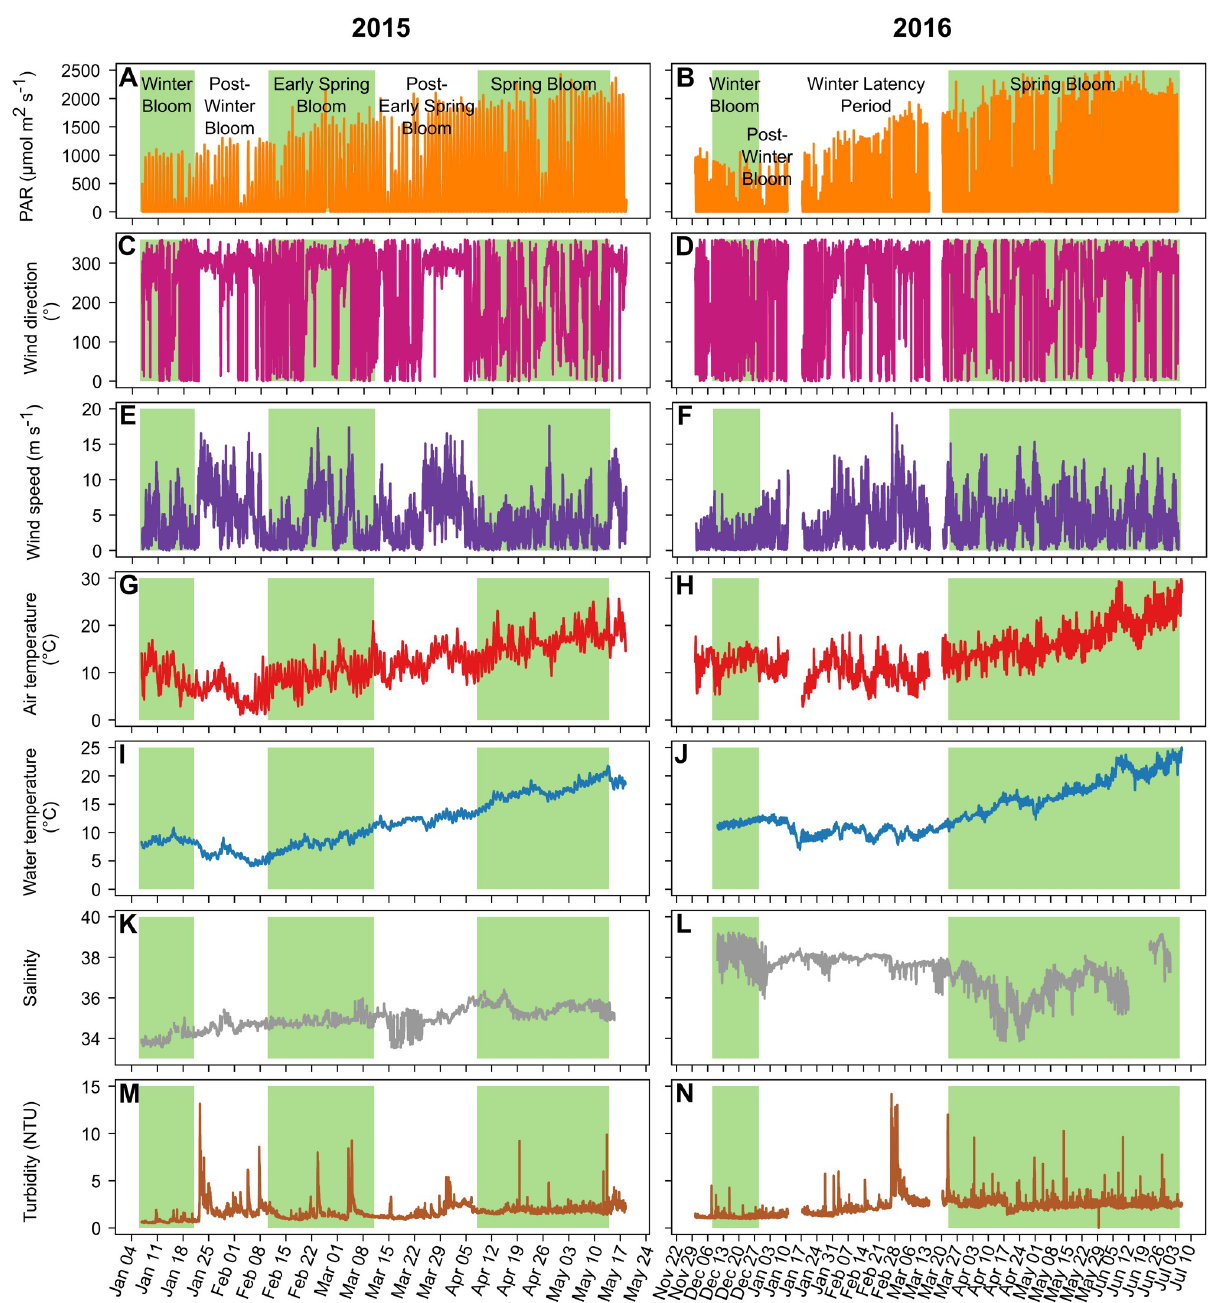
Fig 3. Environmental variables. Main environmental variables for 2015 (left) and 2016 (right). A to H are the meteorological data: PAR (A and B), wind direction (C and D), wind speed (E and F) and air temperature (G and H); and I to N are the hydrological variables: water temperature (I and J), salinity (K and L) and turbidity (M and N). The background colors for the various periods are the same as in Fig